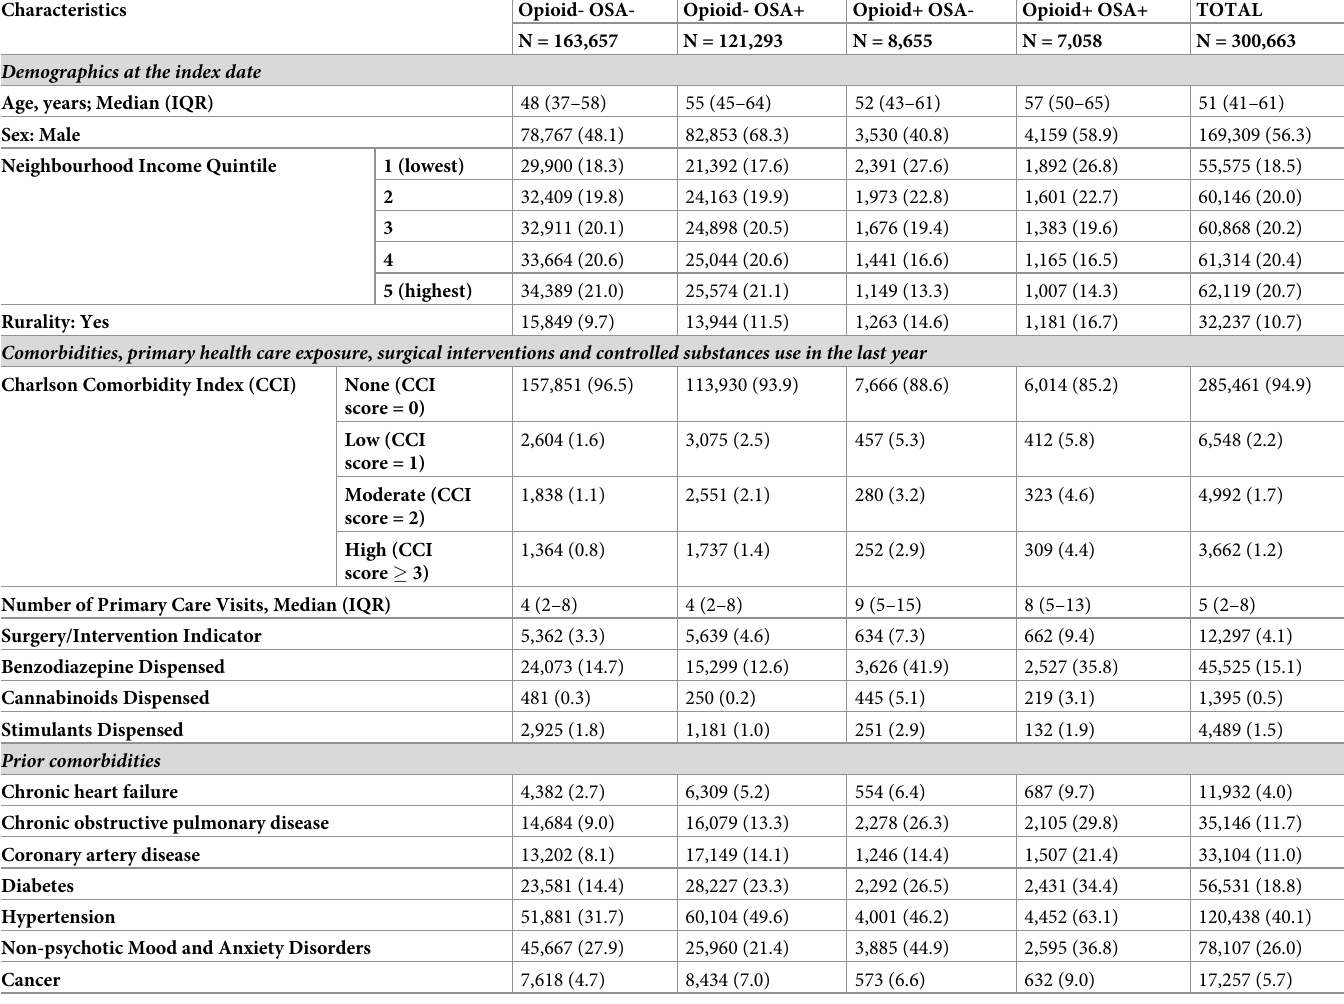
Table 1. Baseline characteristics at the date of the diagnostic sleep study for the entire cohort and by active opioid prescription (being on opioids at the date of the diagnostic sleep study [index date]) and at least a 50% probability of moderate to severe obstructive sleep apnea (OSA) � .